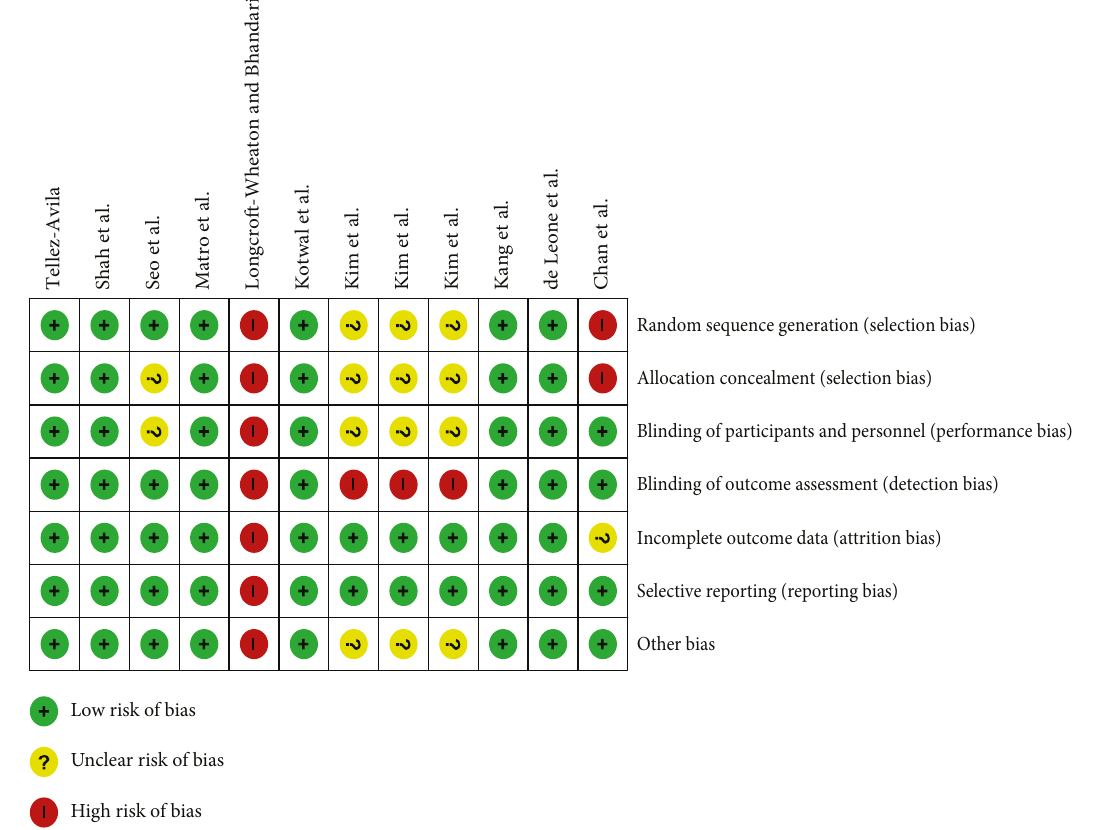
Random sequence generation (selection bias)